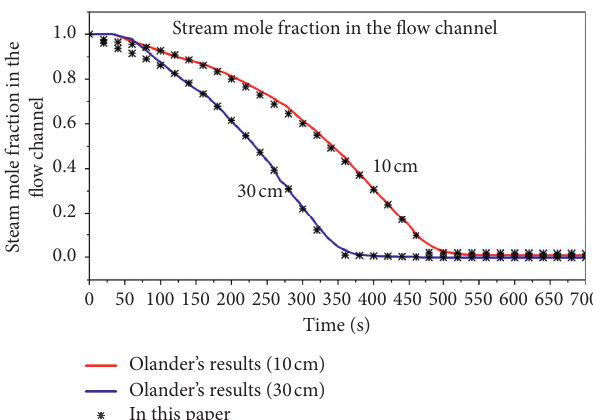
Figure 3: Comparison of steam mole fractions in the flow channel.